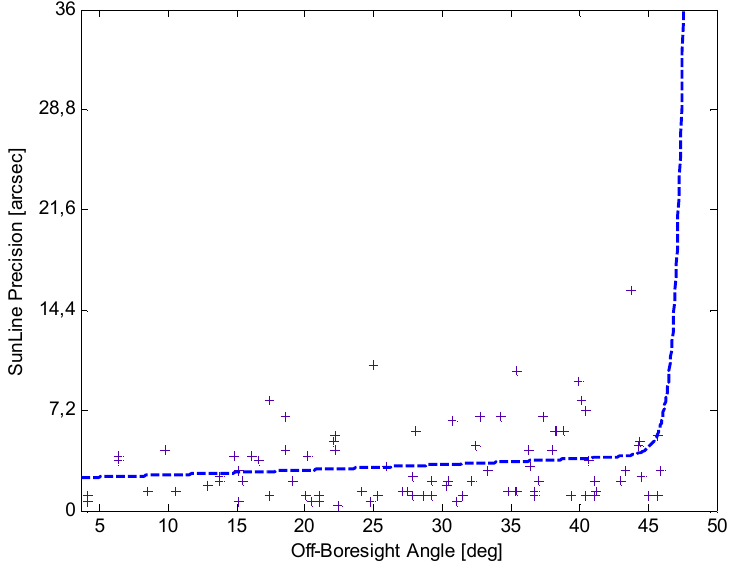
Figure 12. Sun-line precision versus the off-boresight angle for the basic procedure.